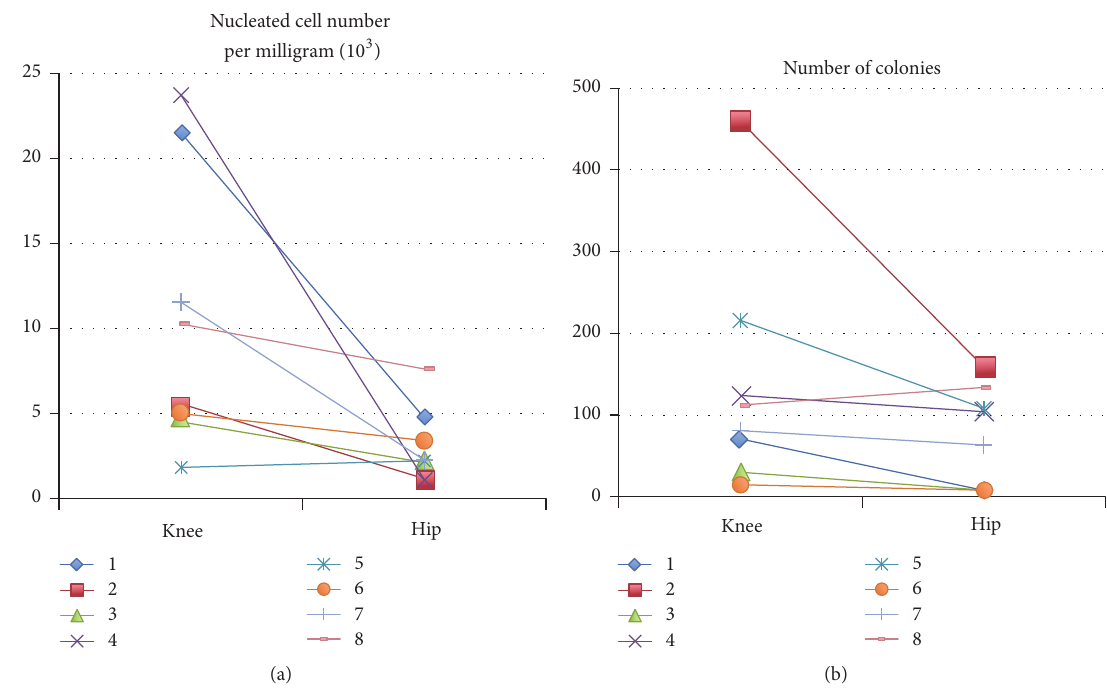
Figure 1: Data on cell samples obtained from the synovium of each case on 8 donors.